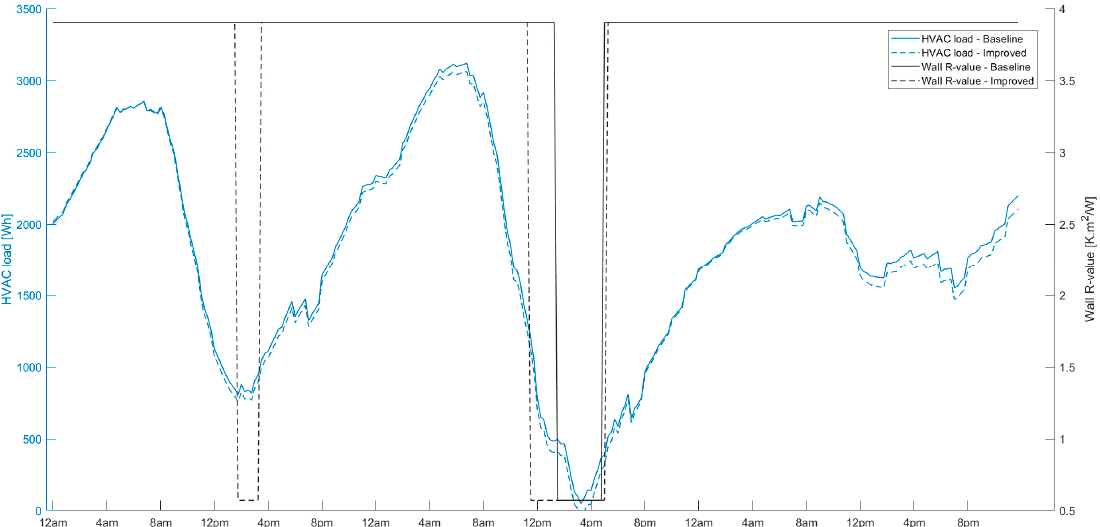
Figure 6. Comparison of wall action for a 3 day period between 4 March and 6 March, showcasing the di ff erence in HVAC energy consumption and SIS wall actions between the baseline wall construction and the improved wall.